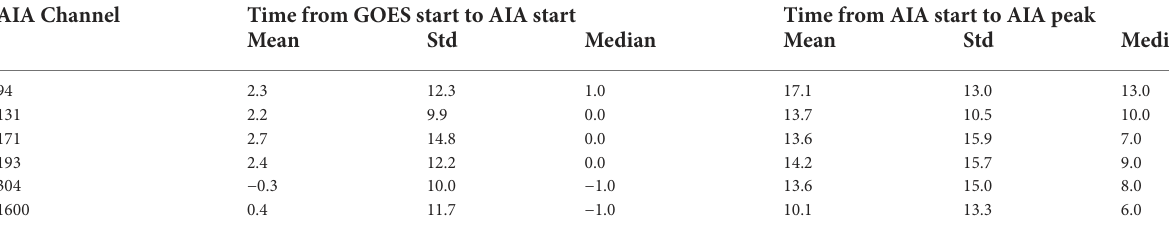
TABLE 2 Mean,standarddeviationandmedianinminutesforcomparisonofflaretiminginAIAchannelsvs.GOES. Time from GOES start to AIA